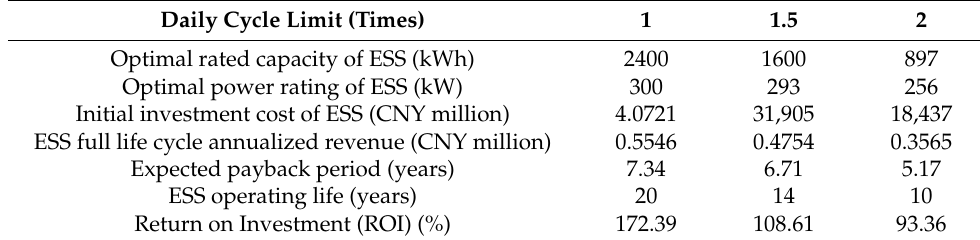
Table 3. Results of optimized configuration of